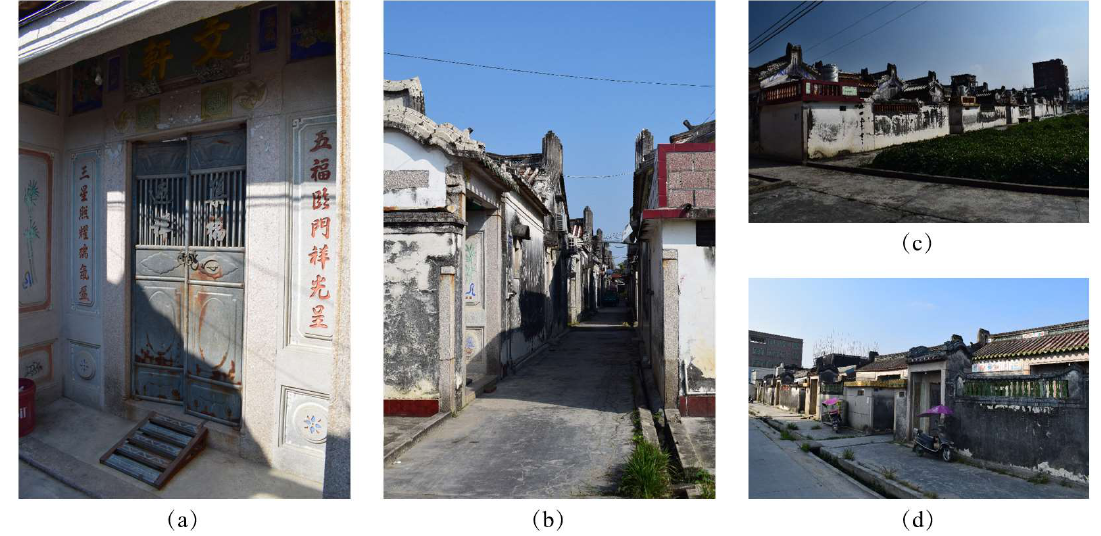
Figure 2. Mansions in Chaoshan style in LJP: ( a ) Shanbing; ( b ) Futan; ( c ) Simapu; and ( d ) Gurao. Table 1. Basic information and list of ascending Sentinel-1A Dataset I in LJP: acquisition date (Date) and acquisition time in UTC (Time). The master image for PS and DS processing is 20170106.